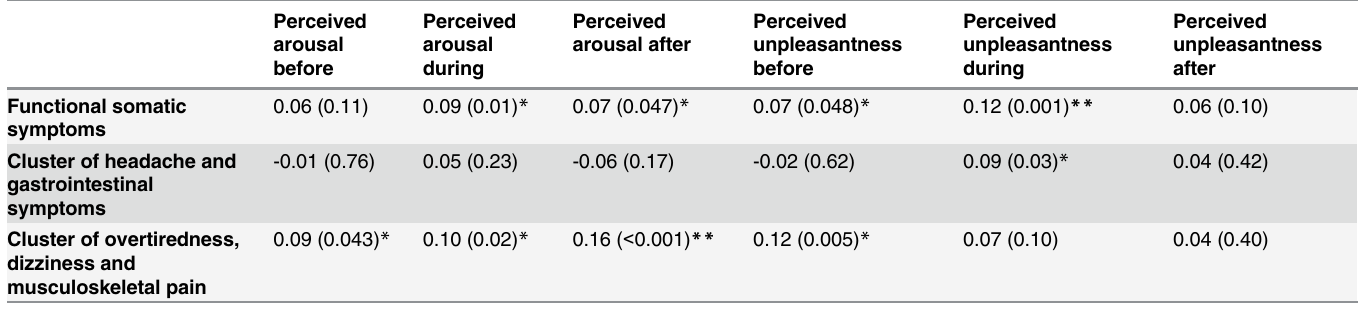
Table 2. The associations between perceived stress before, during, and after the Groningen Social Stress Test (GSST) task and FSS. Perceived arousal before during